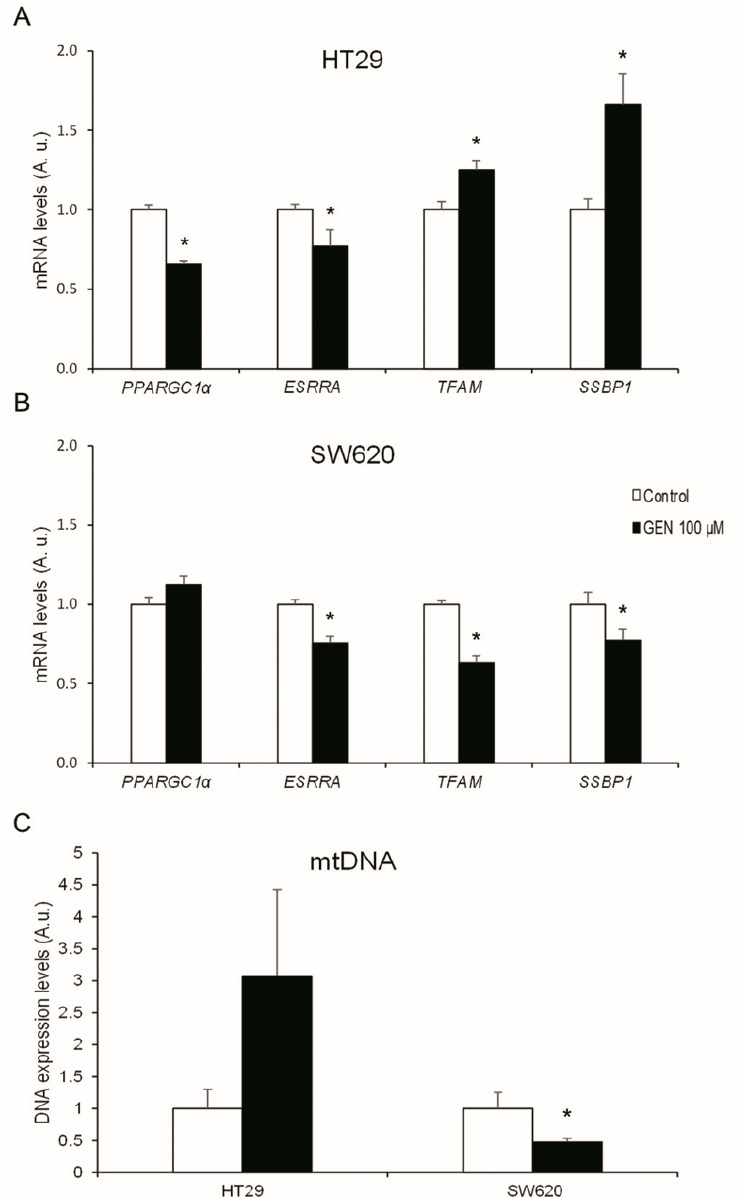
Figure 7. Effects of genistein on mRNA expression levels of mitochondrial biogenesis-related genes ( PPARGC1 α , ESRRA, TFAM , and SSBP1 ) in ( A ) HT29 cells and ( B ) SW620 cells, determined by real-time PCR. Effects of genistein on DNA expression levels of mitochondrial DNA in ( C ) HT29 and SW620 cells determined by real-time PCR. The measurements were made with genistein 100 µ M or 0.1% DMSO (control cells) treatment for 48 h. The coordinate values represent mRNA levels (arbitrary units). Values are expressed as mean ± SEM and control values (DMSO-treated cells) were set at 1.00. GEN, genistein; A.u., arbitrary units. * Significant difference between control cells and genistein-treated cells (Student’s t -test; p < 0.05, n =